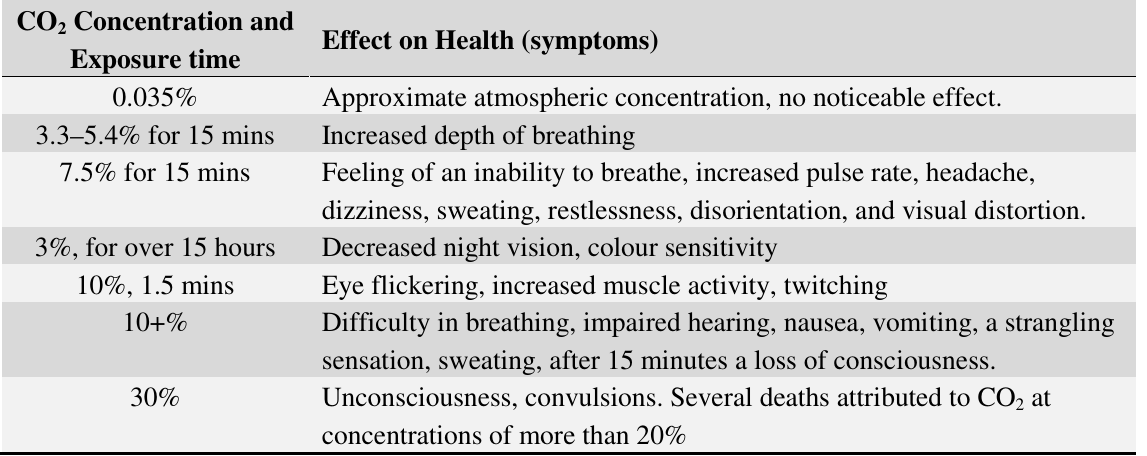
Table 3. Detailing the effects of concentration and exposure time of CO Taken from occupational health and safety website in Canada